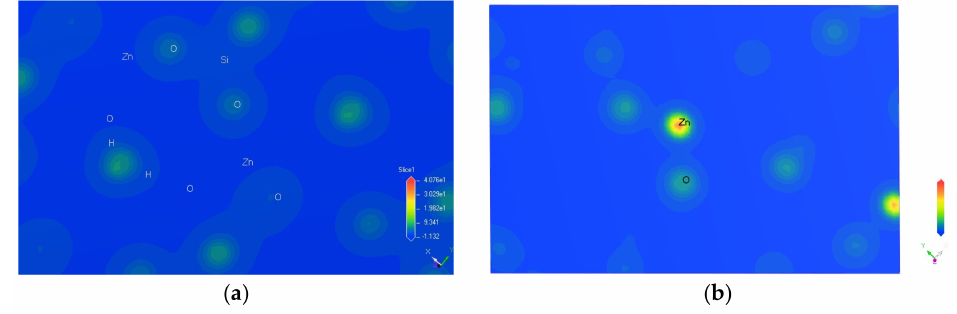
Figure 5. Charge density difference map of hemimorphite. ( a ) Si–O bond; ( b ) Zn–O bond.